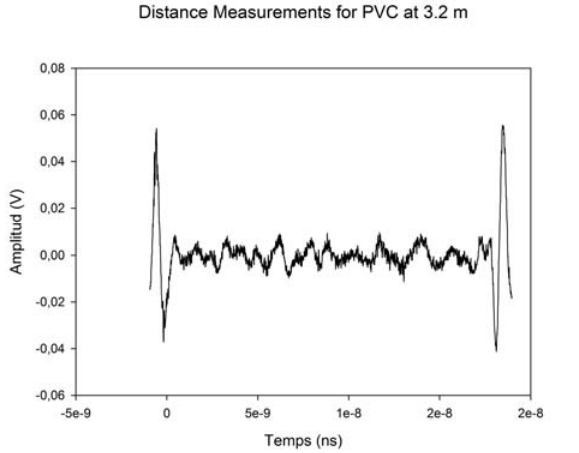
Figure 16: Time-domain response of the radar sensor mea- surement towards a PV C plate located at 320